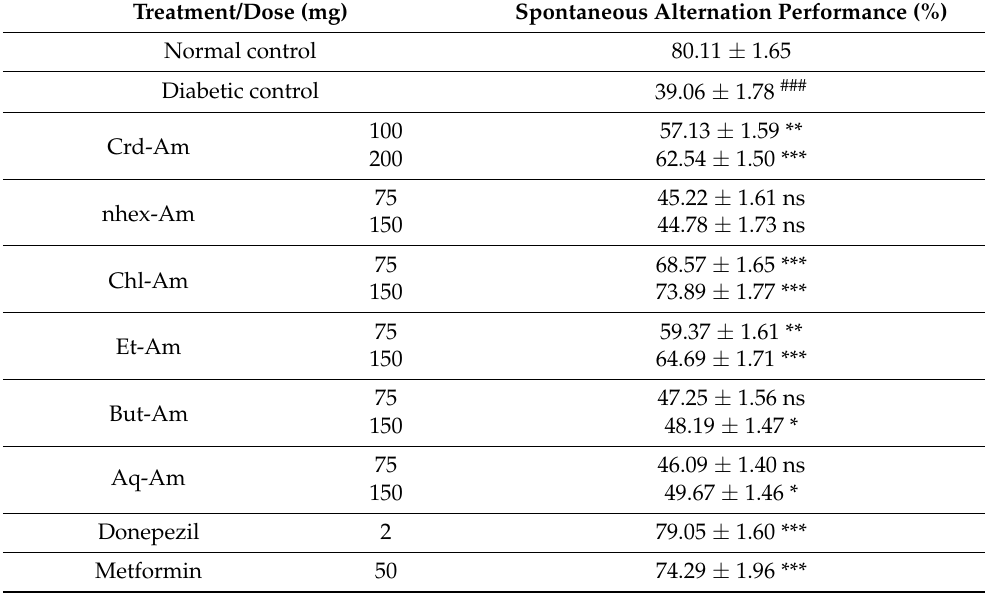
Table 3. Effects of crude extract and fractions on spontaneous alternation performance in behavioral Y-maze